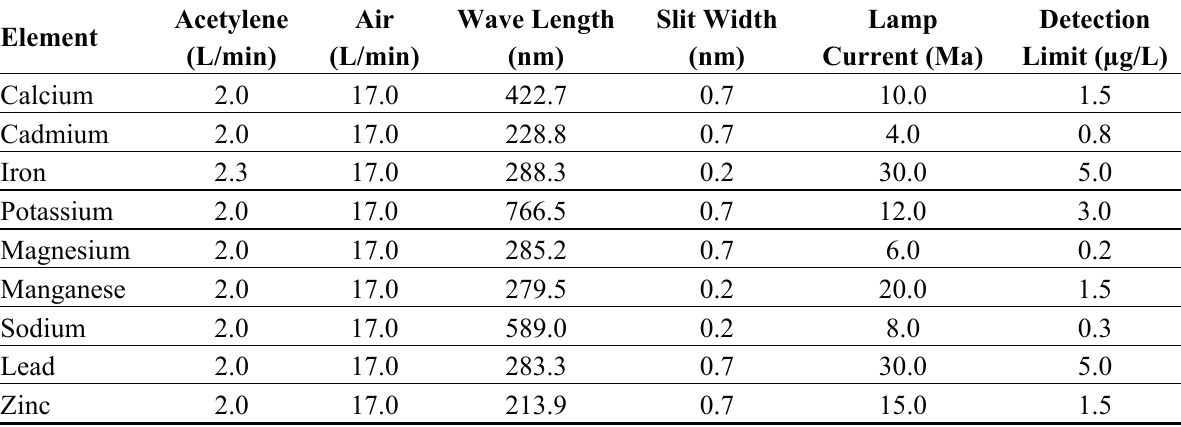
Table 1. Instrumental analytical conditions associated with the analyses of selected